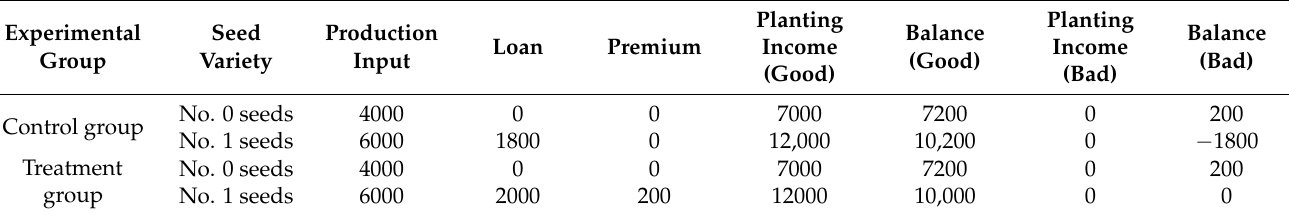
Table 2. Experimental parameter settings comparison of traditional and innovative